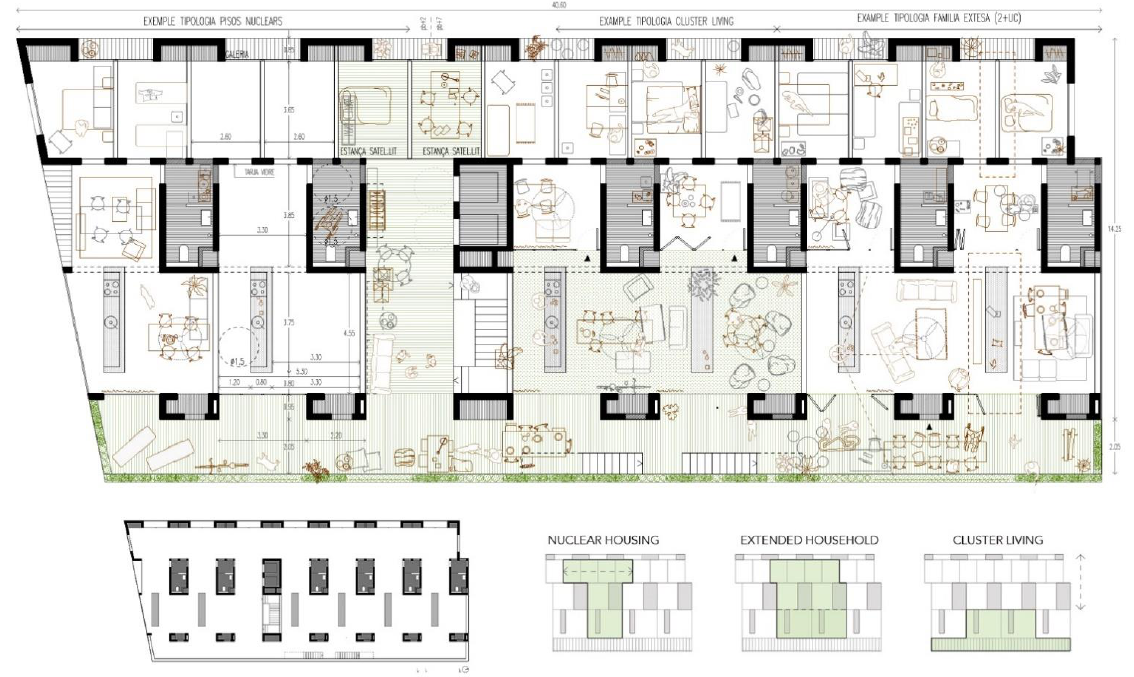
Figure 10. La Quinta Força by Llindarquitectura and Avilla-Royo. Top: plan. Below left: the building is presented without boundaries between dwellings as an open plan to be defined by the cooperative. Below right: the dwelling’s boundaries can be redefined over time and respond to different household structures such as nuclear family, extended family or cluster living. Source: Courtesy of Llindarquitectura and Avilla-Royo.